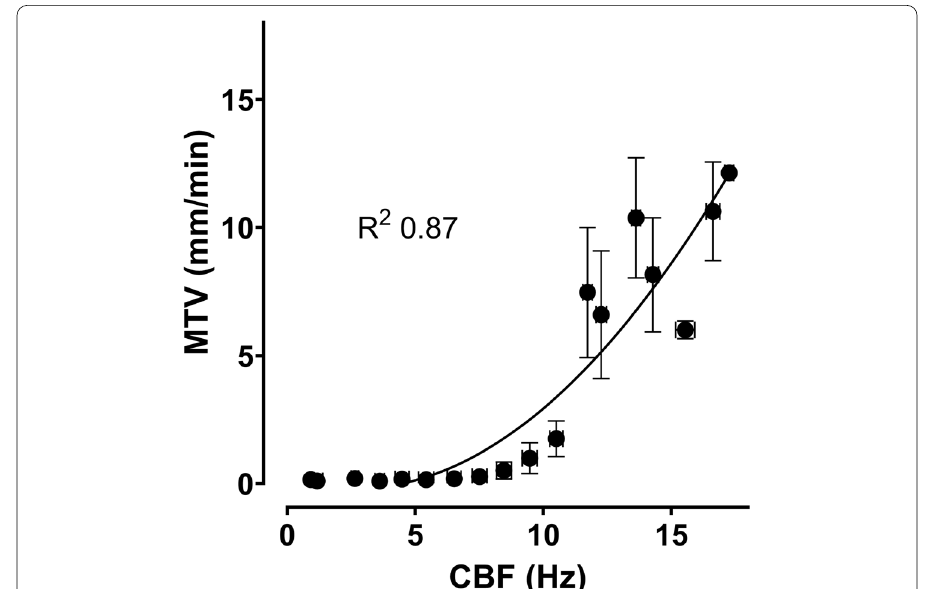
Fig. 5 Correlation between overall mean mucus transport velocity (MTV) and cilia beat frequency (CBF) measurements under different air temperatures and humidities. Non-linear regression gives an R 2 of 0.87 and suggests that a minimum CBF of ca. 6 Hz is required for MTV >